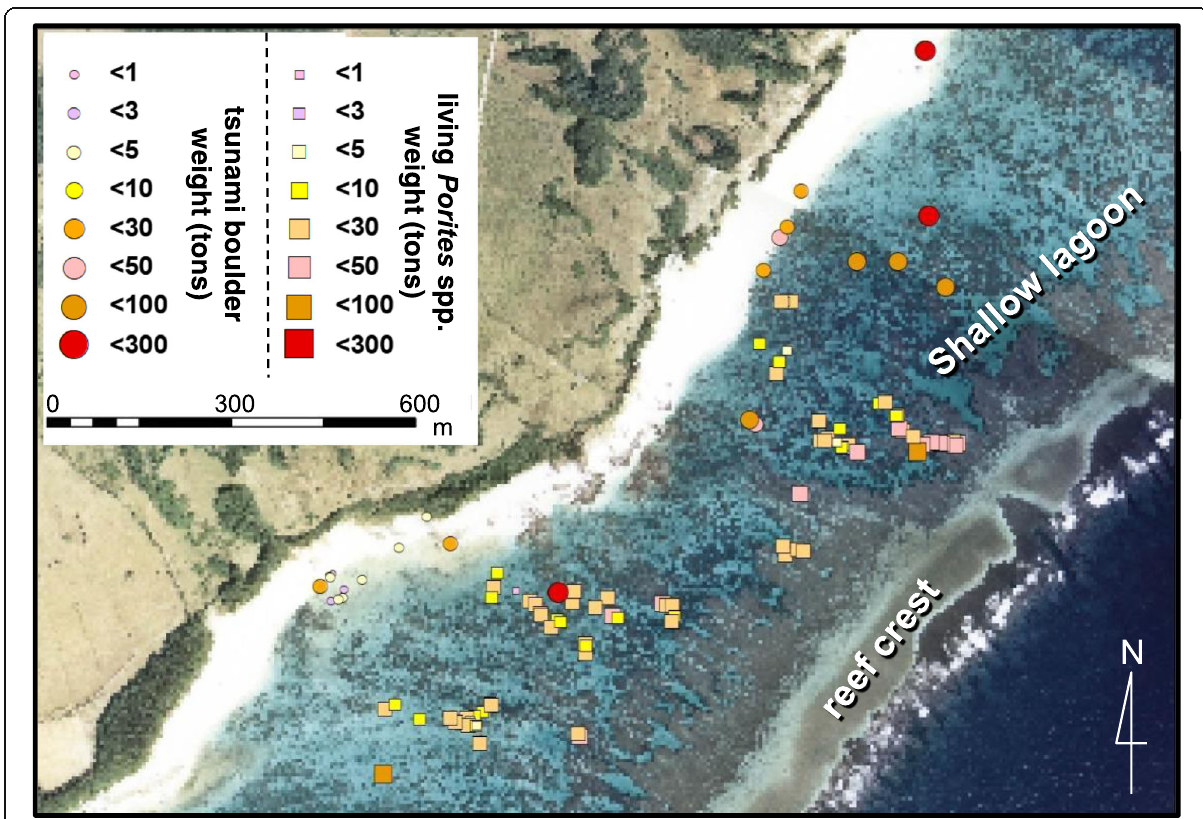
Fig. 4 A map showing the distribution and size of living massive corals of Porites sp. (see Table 1 for the list) and coral tsunami boulders at Ibaruma reef (after Goto et al. 2010b). Aerial photographs were provided by the Ministry of Land, Infrastructure, Transport and Tourism, Government of Japan (1977 photograph). The weight of living corals was estimated based on the assumption of ellipsoidal shape with a wet density of 1.68 g/cm